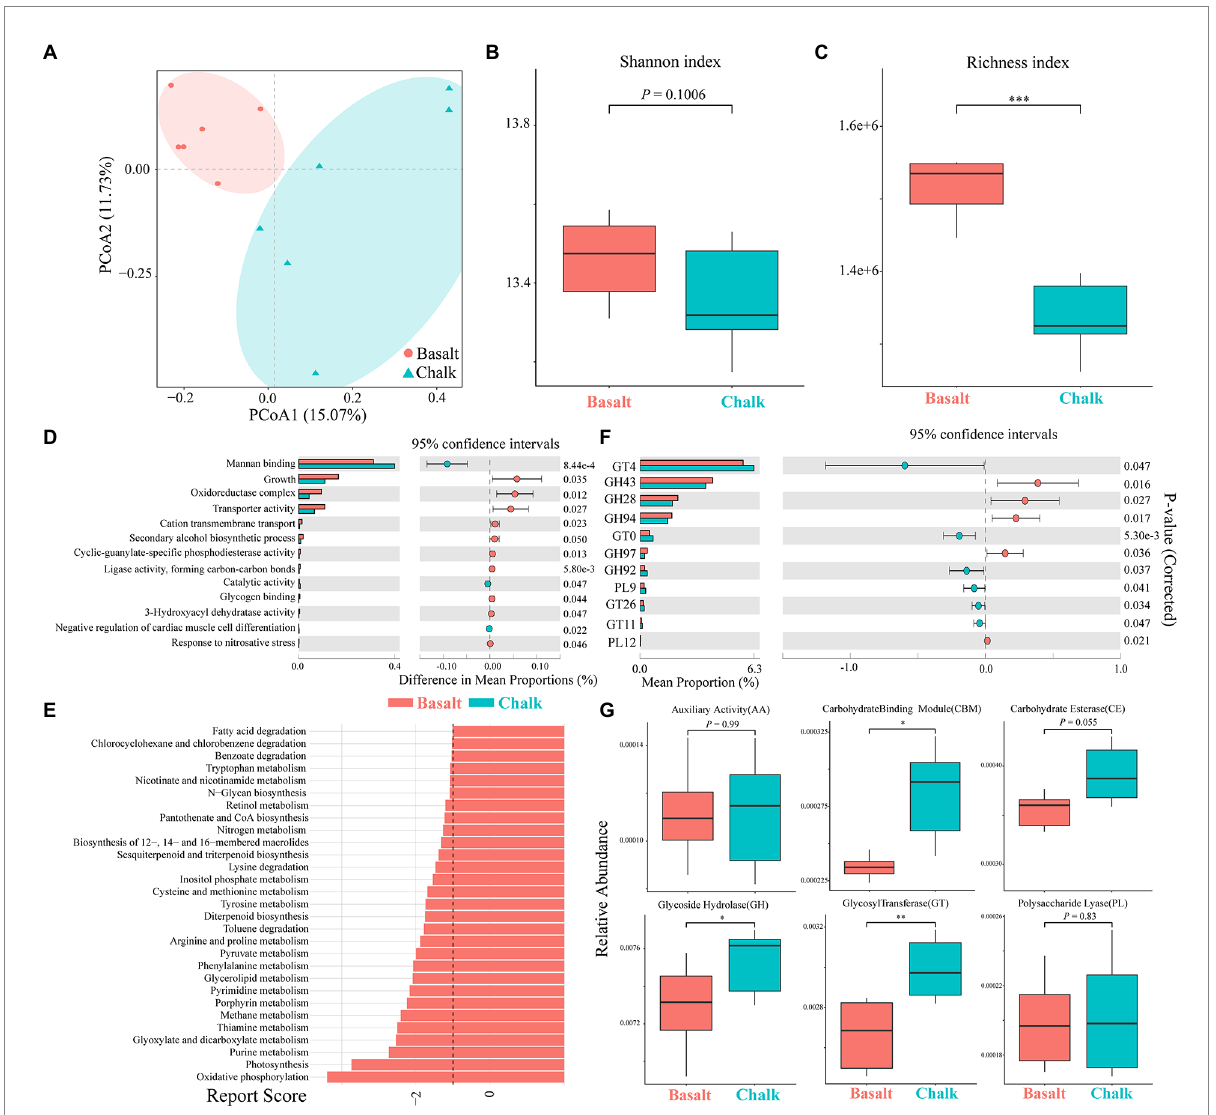
FIGURE 3 Functional compositions of gut microbiomes of basalt and chalk. (A) Principal component analysis shows that the function compositions were clearly separated. (B) Basalt has a higher shannon index based on non-redundant gene sets. (C) Basalt has a higher richness index based on non- redundant gene sets. (D) GO terms with significant differences between basalt and chalk. (E) KEGG pathways with significant differences between basalt and chalk. (F) Carbohydrate active enzymes (CAZyomes) with significant differences between basalt and chalk. (G) Comparison of abundances of different CAZYomes families between basalt and chalk. * p <0.05, ** p <0.01, and *** p